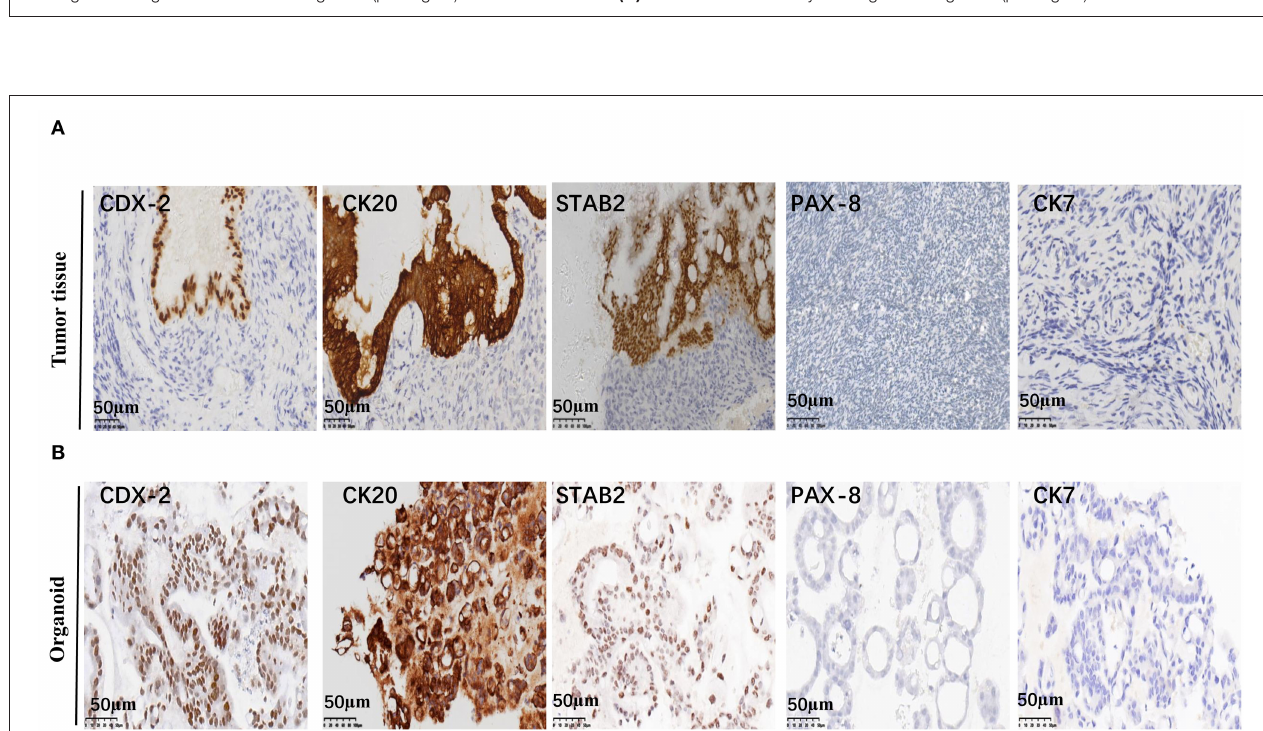
FIGURE 3 | Representative immunohistochemistry staining of MAA. Representative images of CDX2, CK20, STAB2, PAX-8, and CK7 immunohistochemical staining of the original tumor (A) and organoid (passage 8) (B) Scale bar = 50 µ m.